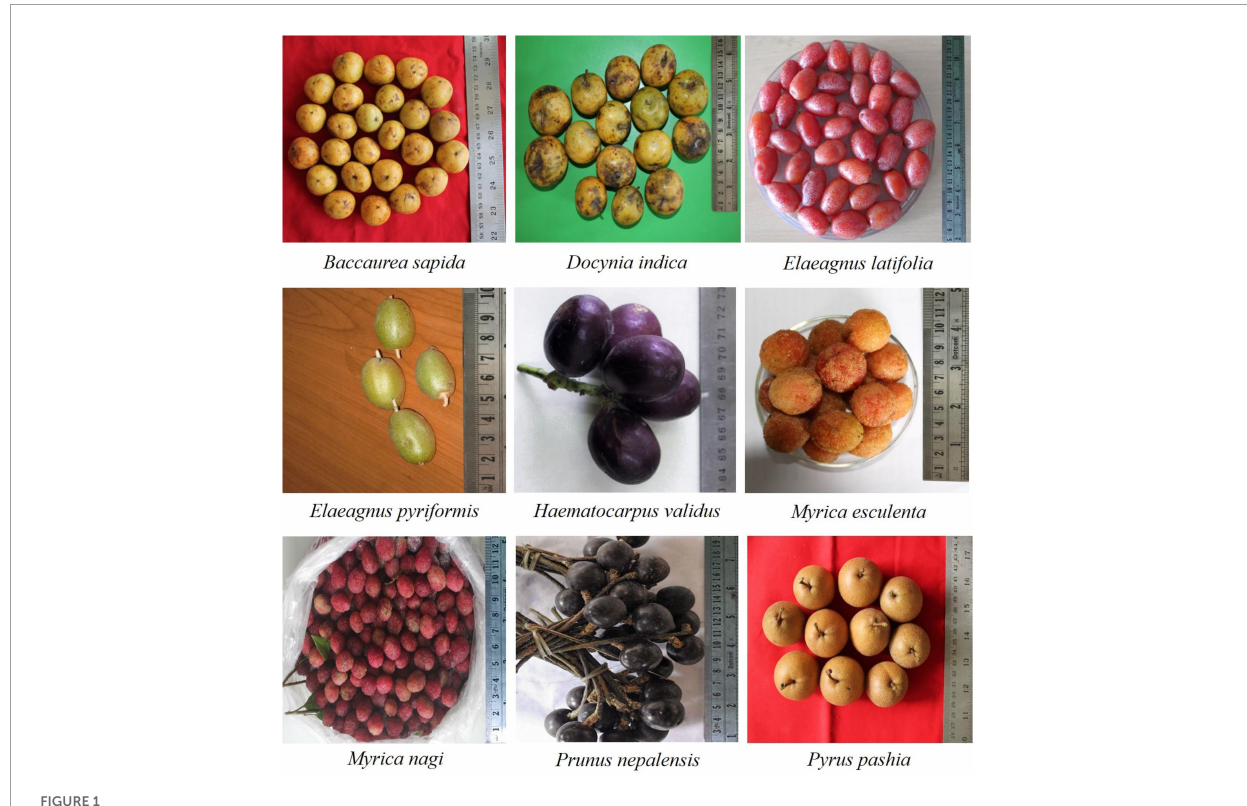
FIGURE1 Fruits of wild edible plants grown in the eastern Himalayas, India.